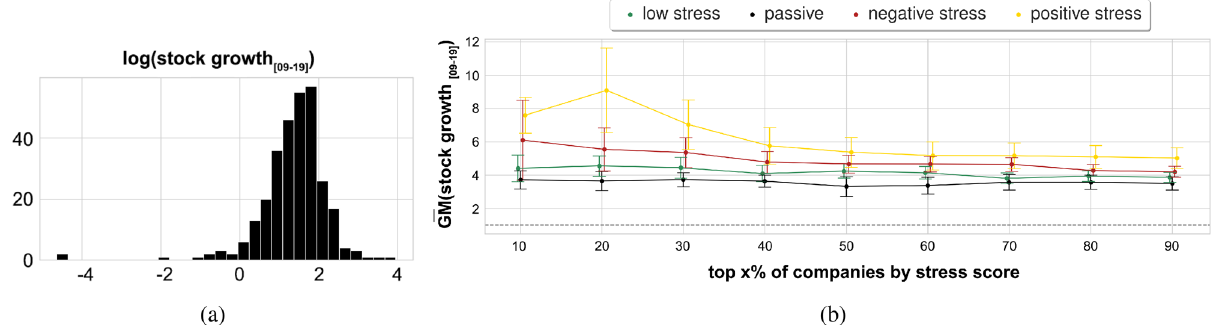
Figure 3. ( a ) Distribution across companies of the logarithm of stock growth values from the average stock price in 2009 and that of 2019 ( stock _ growth [ 09 − 19 ] = stock 2019 / stock 2009 ) showing the stock growth is log-normally distributed. The average stock price for year y ( stock y ) is calculated as the average of the daily Adjusted Closing Prices for the year. ( b ) Geometric mean of the stock growth values ¯ GM ( stock _ growth [ 09 − 19 ] ) for increasing stress score percentiles for the companies of a given stress type. Error bars represent geometric √ N · σ( log ( stock _ growth [ 09 − 19 ] )) standard error GSE ( stock _ growth [ 09 − 19 ] ) = ¯ GM ( stock _ growth [ 09 − 19 ] )/